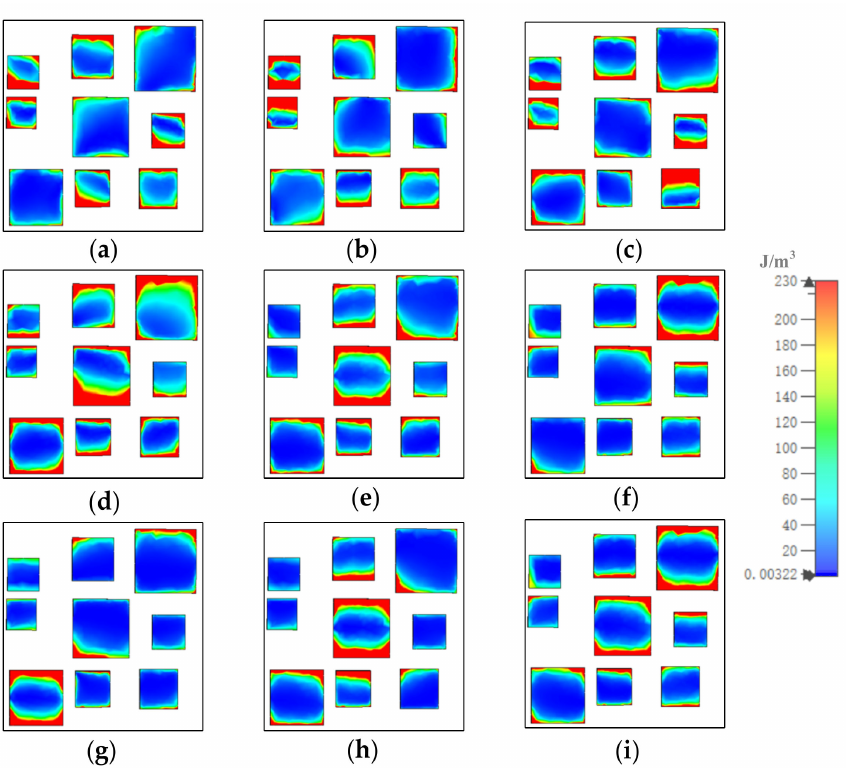
Figure 7. The distribution of electric field energy in top gold layer at ( a ) 8.5, ( b ) 9.13, ( c ) 9.88, ( d ) 10.86,